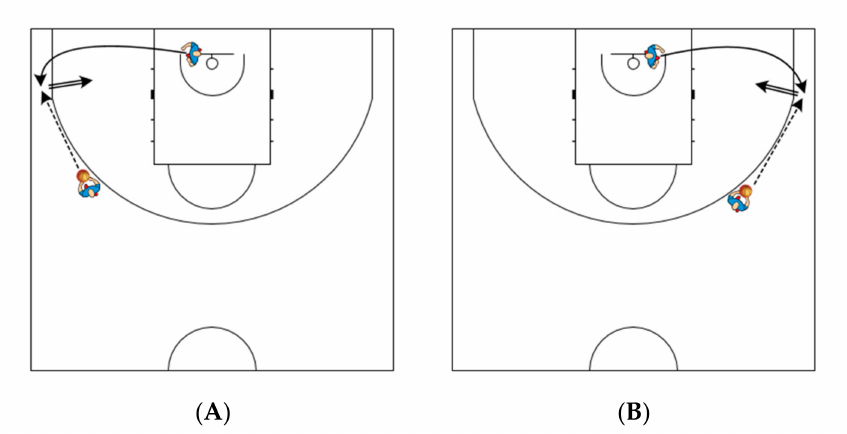
Figure 2. ( A ): 3-pt shooting after curl-cut from the left side. ( B ): 3-pt shooting after curl-cut from the right